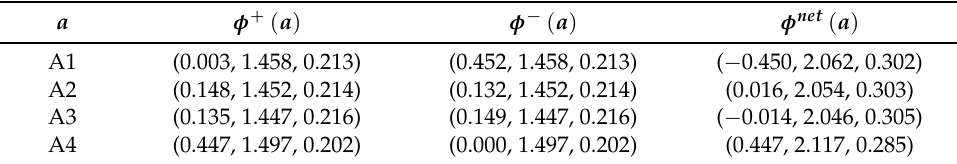
Table 9. The positive leaving flow and the negative entering flow.